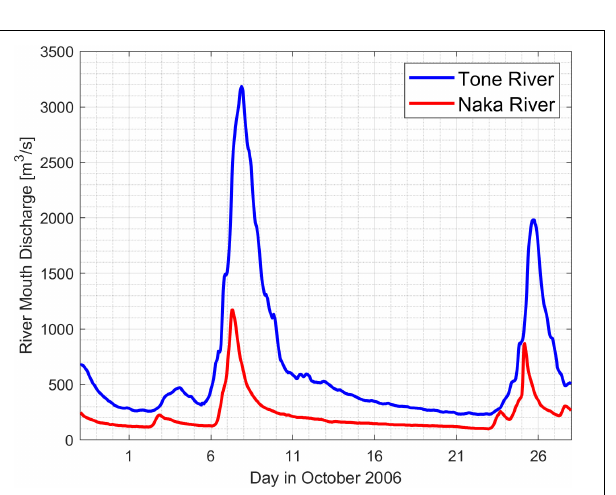
FIGURE 8 | Observed time series of Tone and Naka River mouth discharge from September 28 to October 27 (blue: Tone River, red: Naka